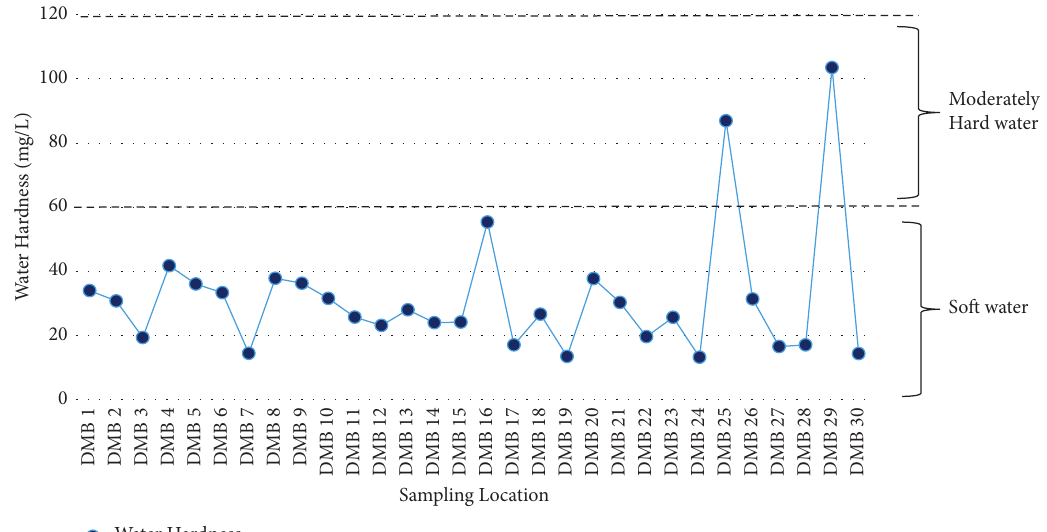
Figure 5: Total water hardness in drinking water samples collected from Dambethalawa GND, Ampara district, Sri Lanka. All data were presented as the mean of three replicates (mg/L).